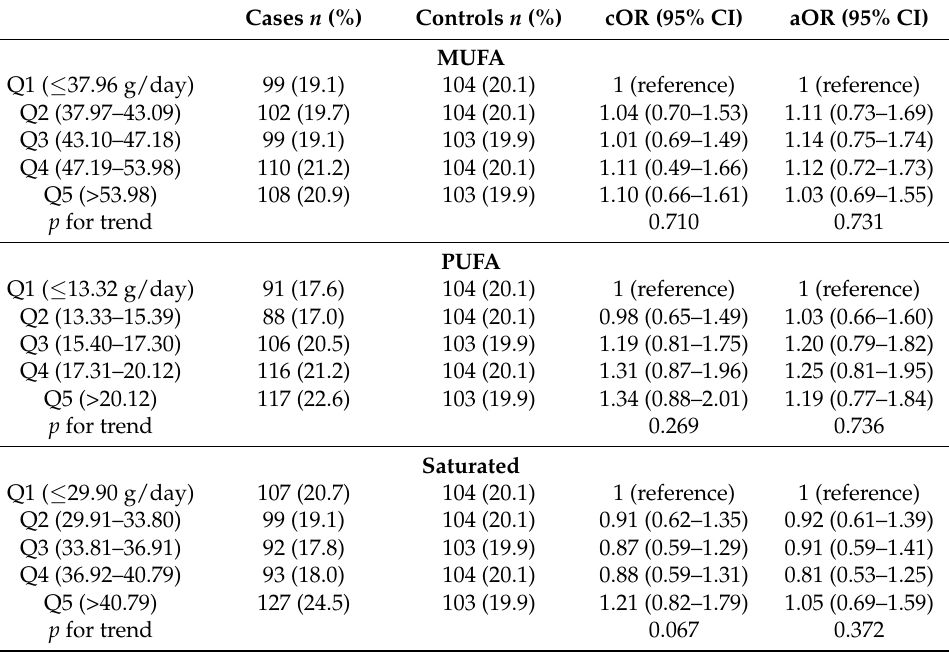
Table 6. Type of fatty acids in quintiles (g/day) and risk of